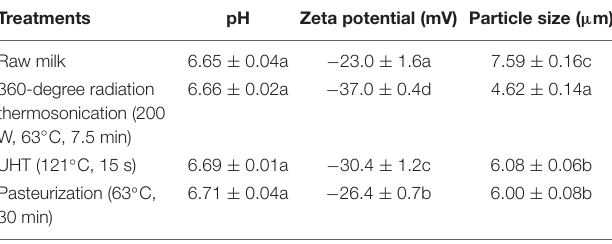
TABLE 4 | pH, zeta potential, and particle size of milk after various treatments.